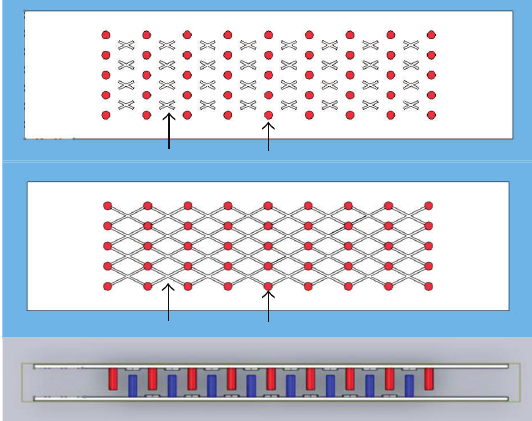
Figure 14: Broken rib, full rib array, and side view of staggered pin fin configuration from Siw et al. [6].